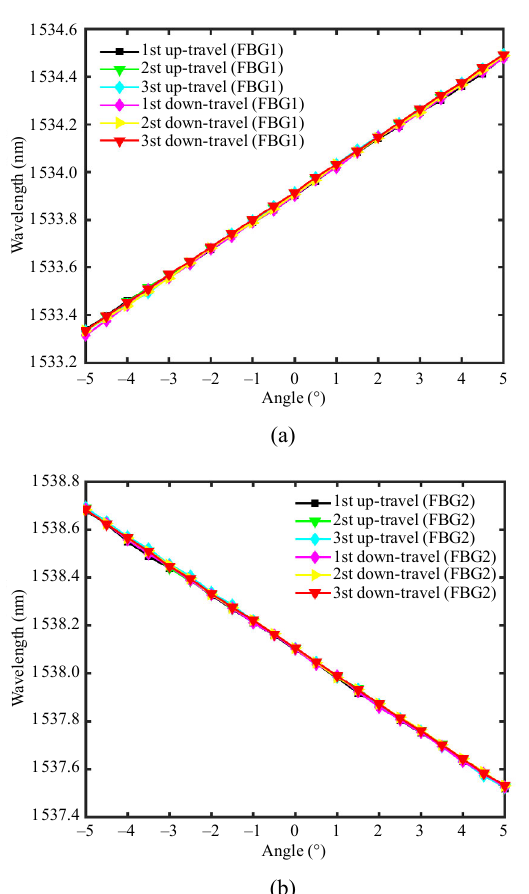
Fig. 10 Corresponding relationship between the wavelength shifts and tilt angle: (a) FBG1 and (b) FBG2.